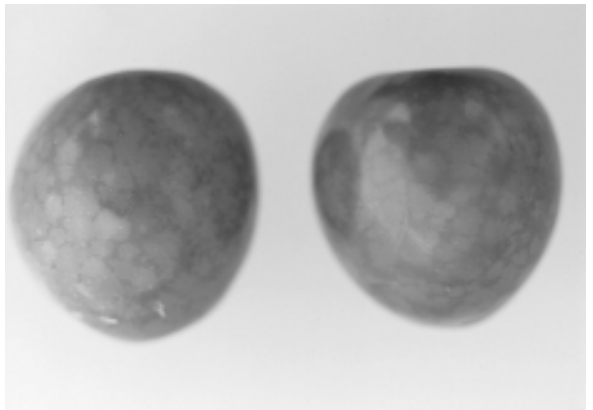
Fig. 2. Fruit of plum cv. Sorriso di Primavera with ir- regular reddish lines on the skin.